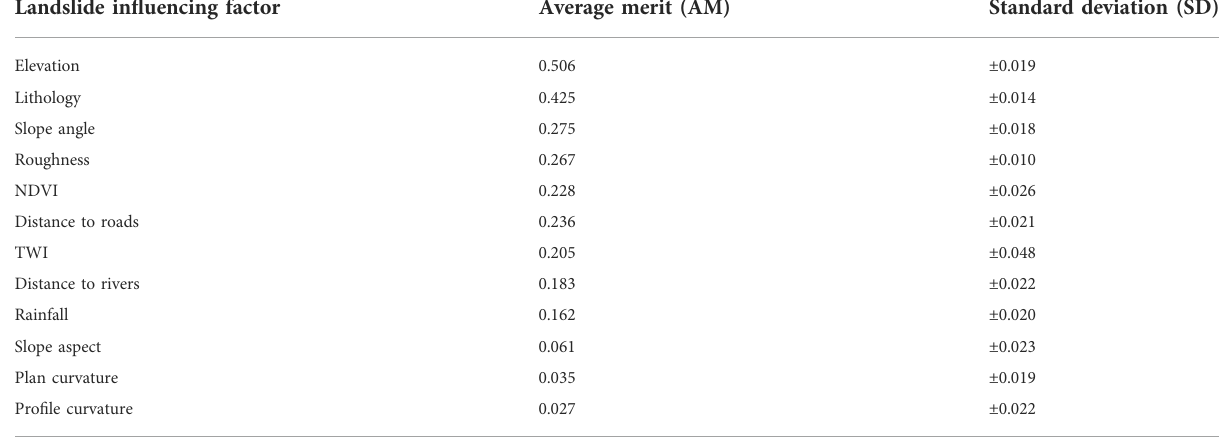
TABLE 2 Importance of in fl uencing factors based on correlation attribute evaluation (CAE).